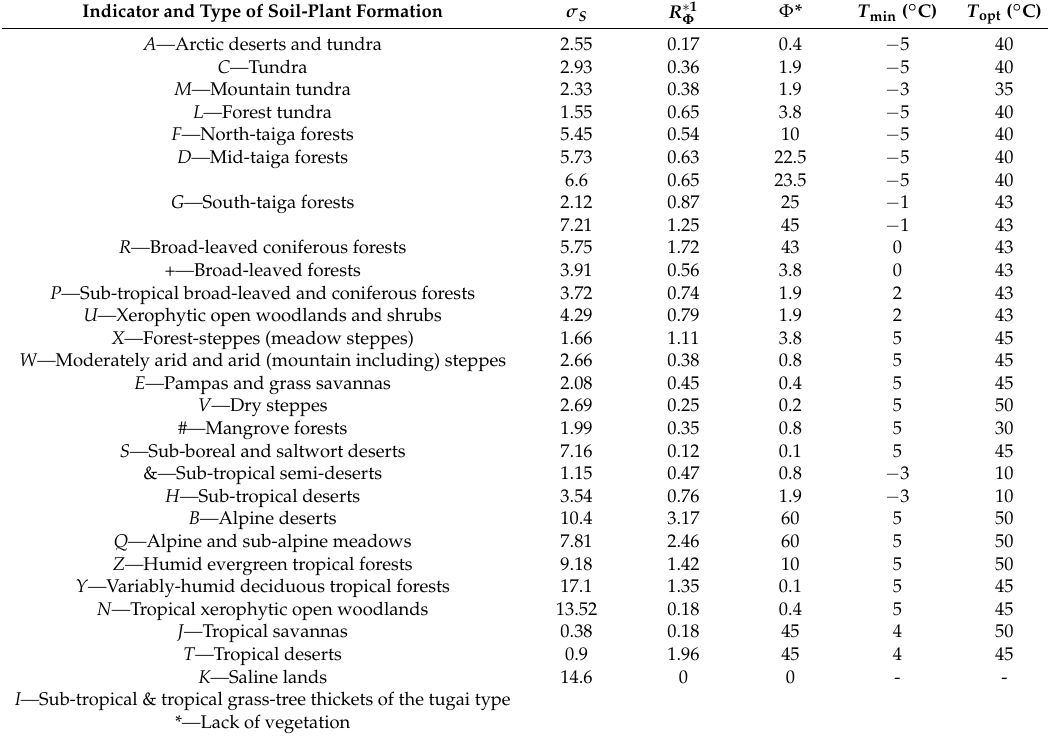
Figure 7. Spatial distribution of the types of soil-plant formations presented in Table 3. Biome indicator is explained in Table 3. Table 3. Quantitative characteristics of the formation types of the land vegetation [60,63,73,74]. Notation: σ S is the biome area (mln km 2 ), R ∗ is the annual increment of plants (kg/m 2 /year), Φ * is the phytomass (kg/m 2 ). T min and T opt are minimal and optimal temperatures for photosynthesis, respectively. Indicator and Type of Soil-Plant